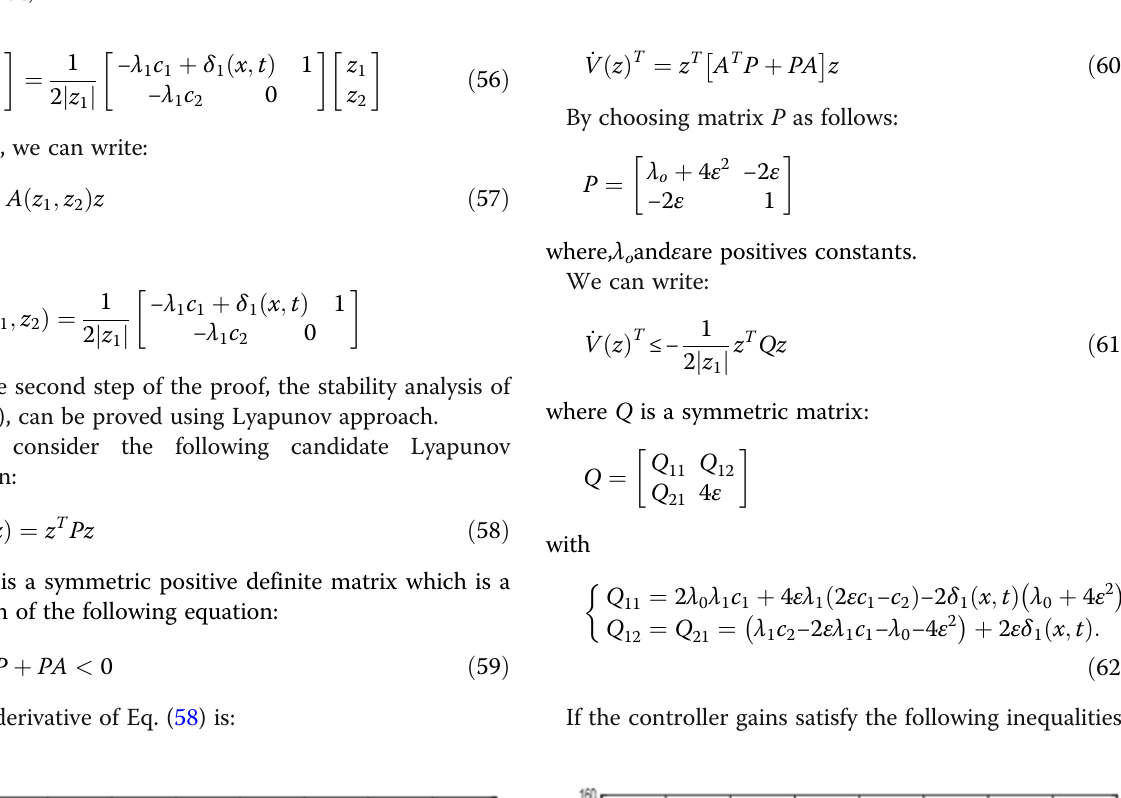
Fig. 12 Electromagnetic torque tracking performance for PI controller